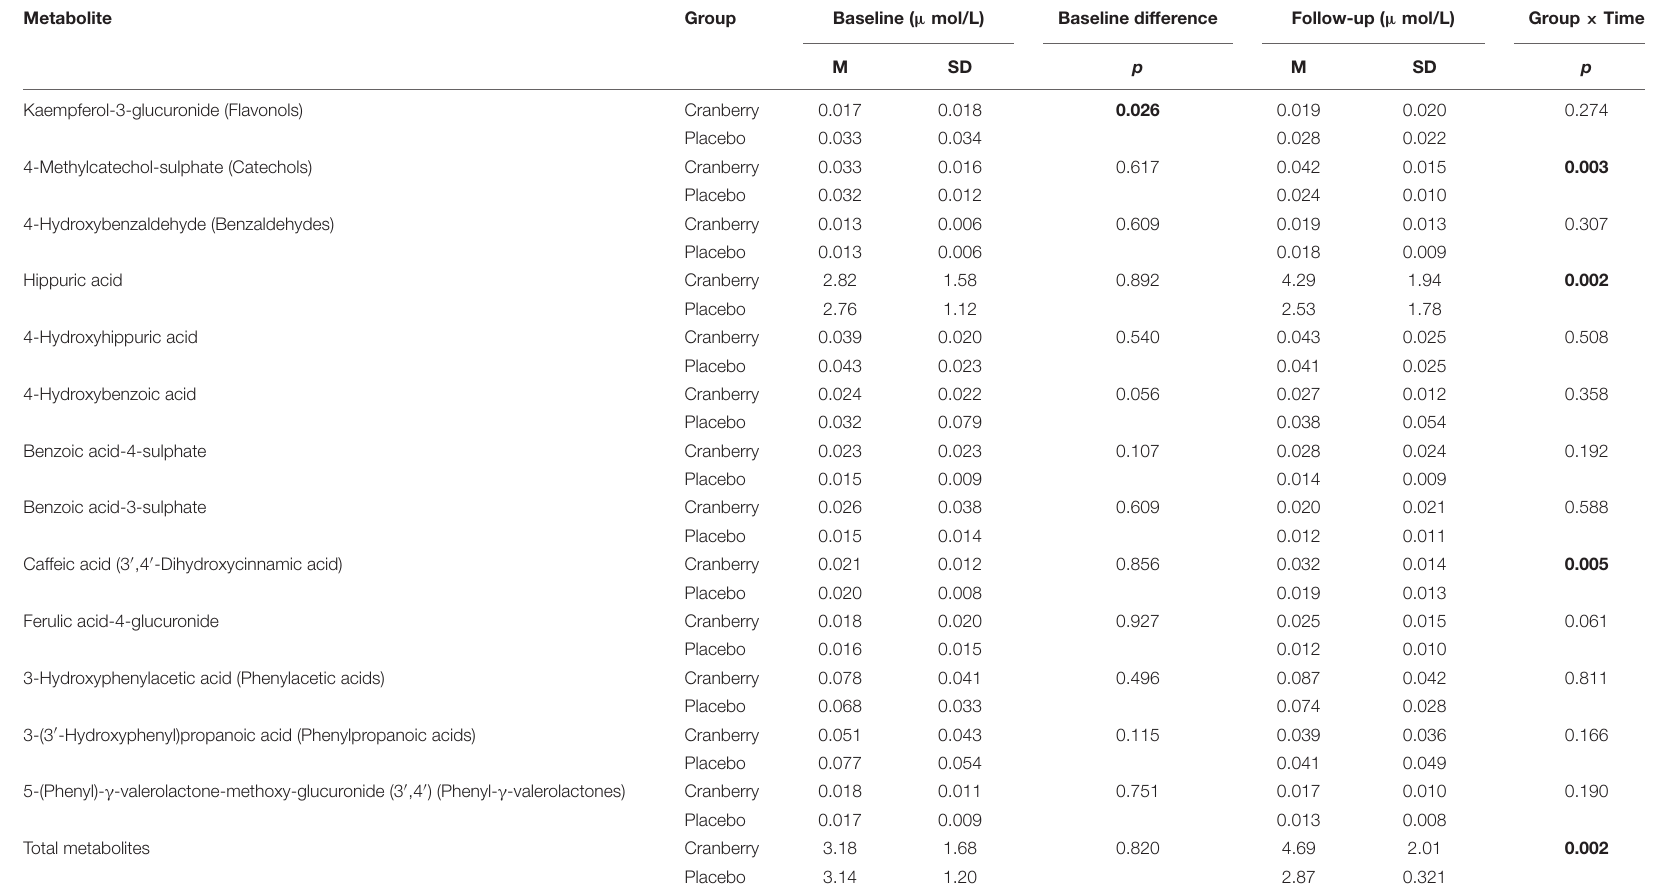
TABLE 5 | Plasma (poly)phenol metabolites at baseline and follow-up visits in µ mol/L. Metabolite Group Baseline ( µ mol/L) Baseline